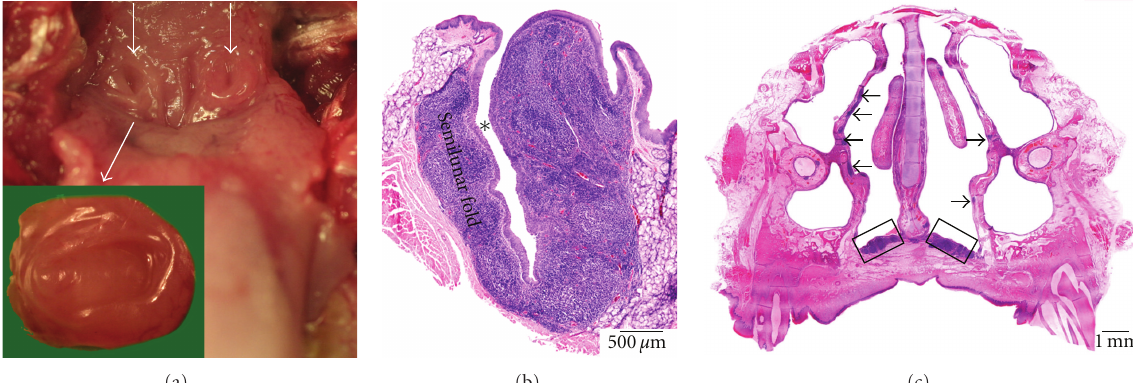
Figure 8: Anatomical localization and histological characteristics of the rabbit tonsils. (a) Rostral view on the paired palatine tonsil (arrows). An excised palatine tonsil is illustrated at higher magnification in the insert. (b) Histological section through a palatine tonsil. The tonsillar fossa is indicated by the asterisk. (c) Histological cross-section through the rabbit nose showing the locations of NALT. Organized lymphoid tissue is present at the bottom of the ventral nasal meatus (boxed areas). Di ff use lymphoid tissue is located along the mucosal linings of the lateral walls of the nasal cavity (arrows).